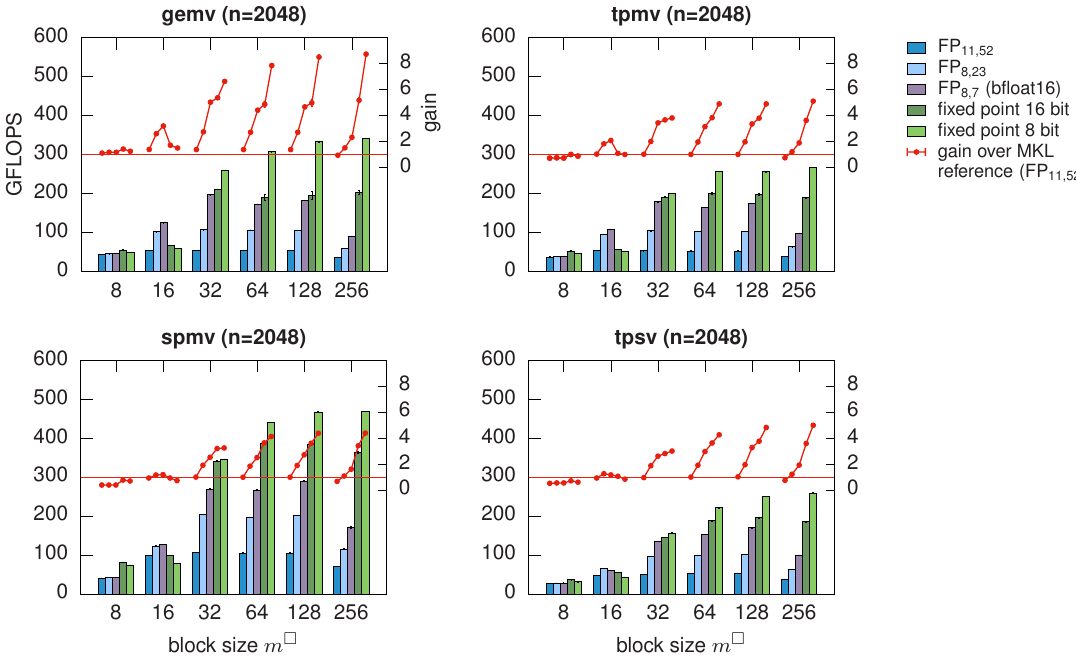
Figure 2. Run times of BLAS level 2 operations on 2048 smoothers with mixed precision. Depending on the access patterns, a speedup over the Intel Math Kernel Library (MKL) almost on par with the compression factor can be achieved